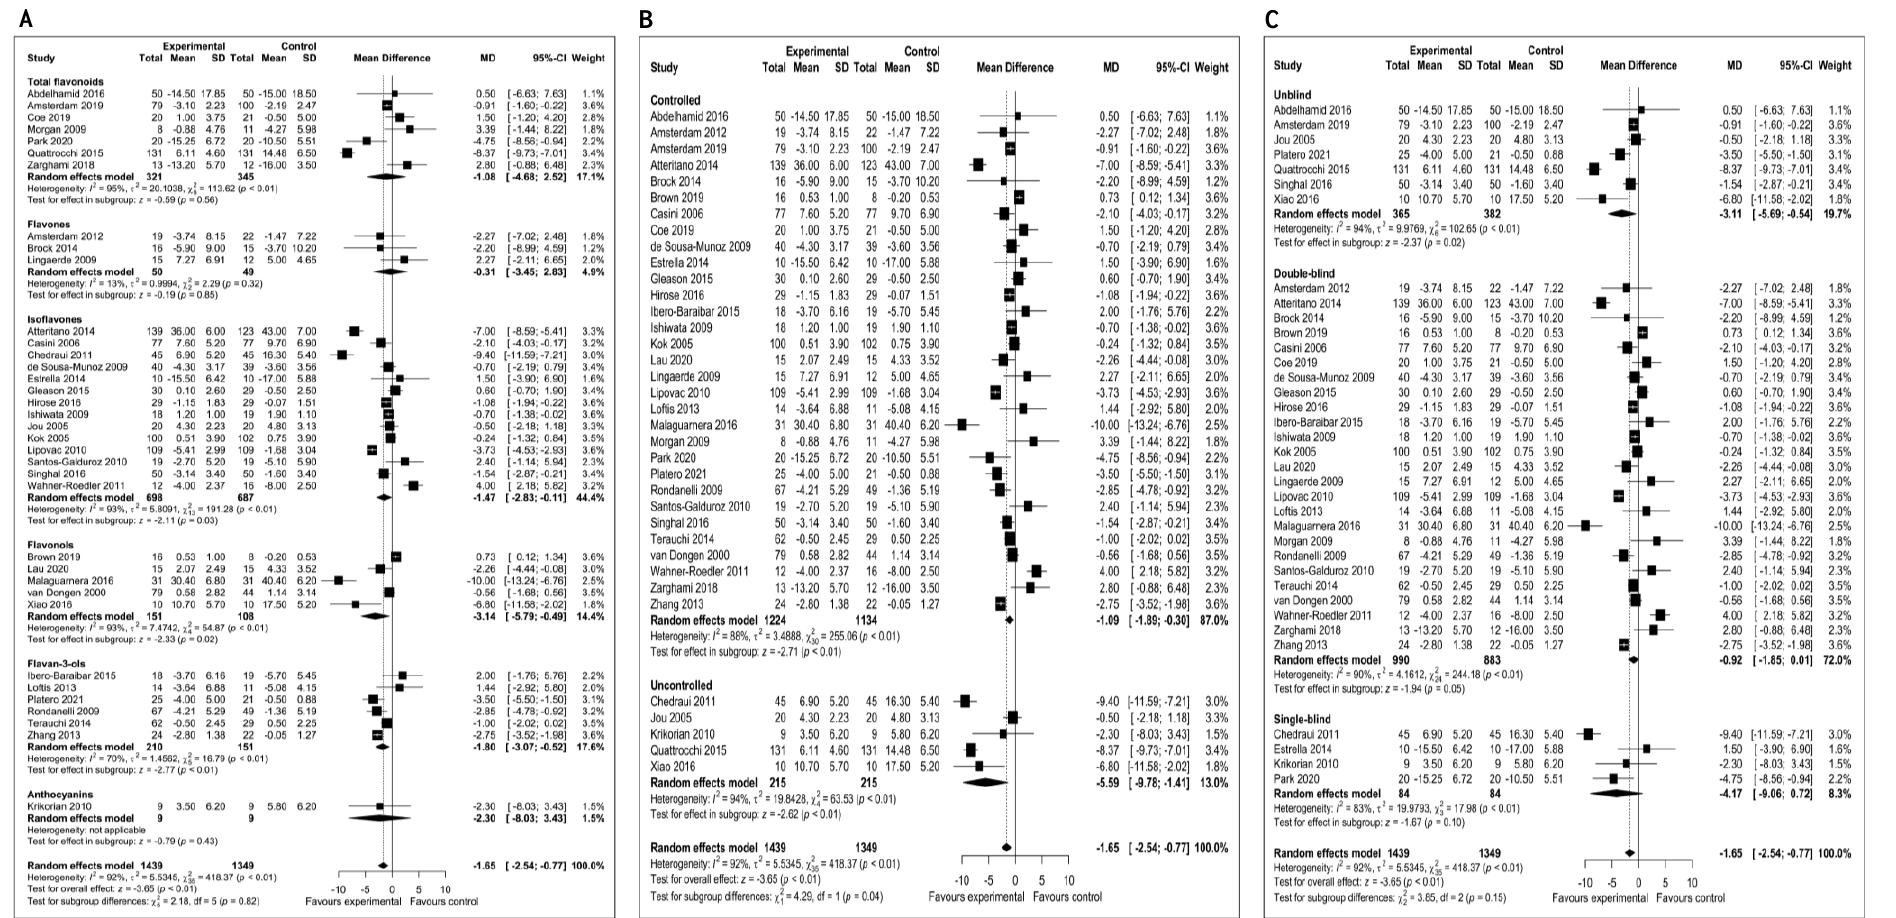
Figure 3. Forest plots for subgroup analyses. ( A ) Forest plot based on the type of flavonoid subclass; ( B ) type of clinical trial (controlled and uncontrolled) and ( C ) level of blinding.